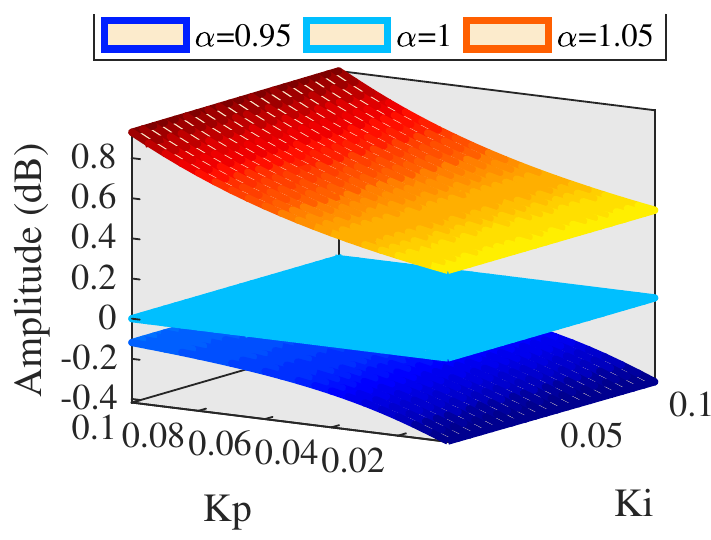
Figure 17. Amplitude of AMFC ( α = 0.95 to